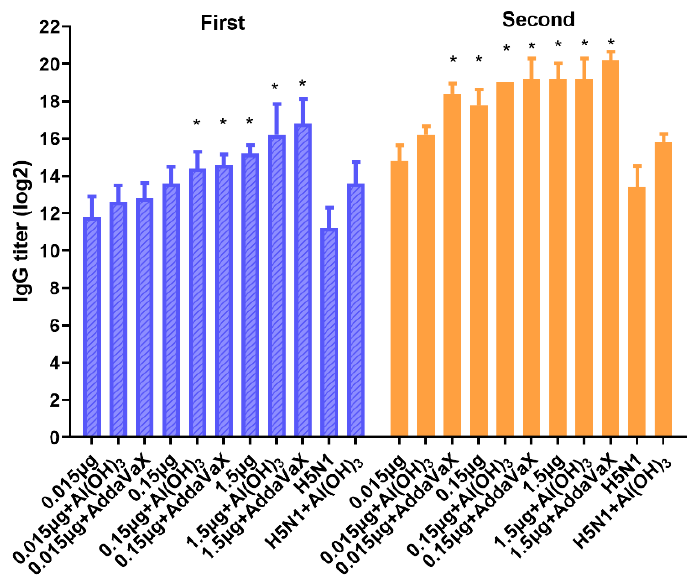
Figure 2. Humoral immune response elicited by H5N8 inactivated vaccine with or without adjuvants. BALB/c mice ( n = 5) were immunized twice with various doses of H5N8 inactivated vaccines with or without adjuvants. The titers of virus specific IgG were detected by ELISA at day 21 post the first or last immunization. An amount of 2 µ g/mL of H5N8 inactivated vaccine was used for plate coating. Comparing the vaccination effect among various formulations, an asterisk * indicates a significant difference ( p < 0.05) detected by one-way ANOVA.